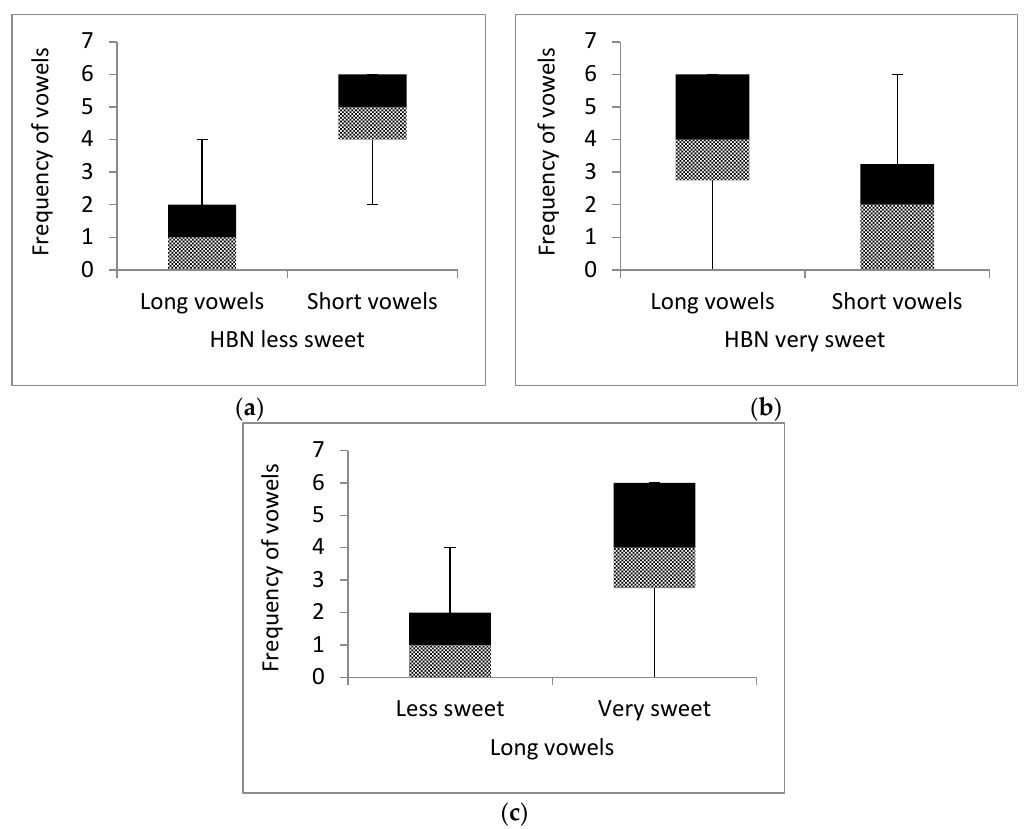
Figure 1. Frequency of long vs. short vowels in Hypothetical Brand Names created by participants in Study 2. (Boundary of the black and patterned box demarcates the median; black box shows 3rd quartile ‐ median and patterned box shows median ‐ 1st quartile).